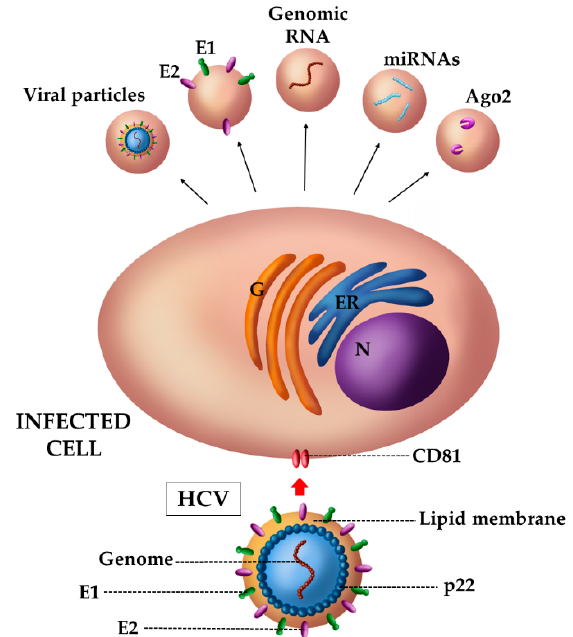
Figure 3. Schematic representation of EVs released by HCV-infected cells. EVs derived from HCV-infected cells carry both viral and host cell components that promote viral dissemination and immune pathogenesis. HCV-EVs carry entire viral particles, thus hiding them to immune system and allowing the virus to enter the recipient cells using uncanonical receptors. In addition, HCV-EVs transfer the glycoproteins E1 and E2, viral genomes as well as miRNAs, such as miRNA-19a, miRNA-192 and miRNA-122, and host proteins including Argonaute 2 (Ago2), the effector of RNA interference (RNAi) that associates with Hsp90. Nucleus (N); endoplasmic reticulum (ER); Golgi complex (G).